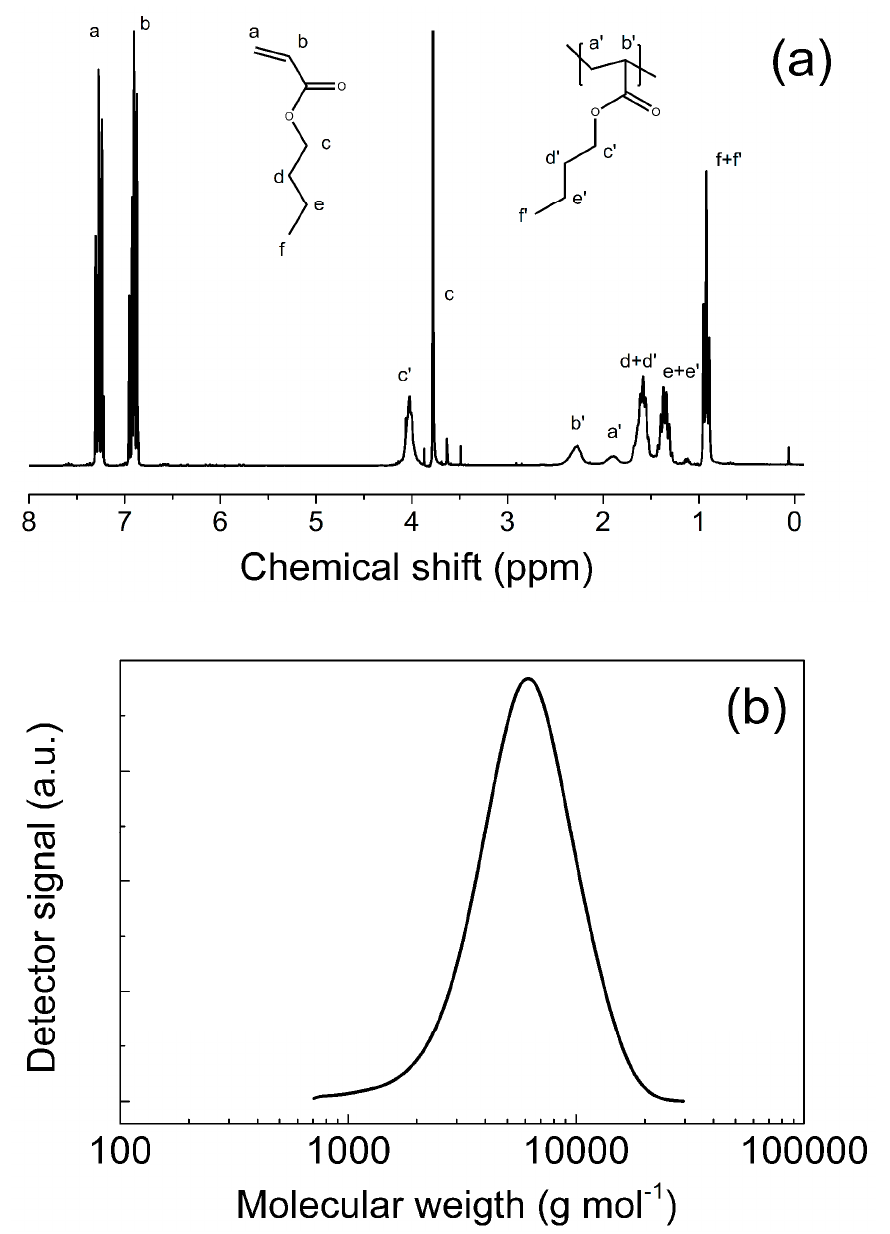
Figure 2. 1 HNMR spectra for n-butyl acrylate and PBA ( a ) and GPC trace of the controlled polymerization of PBA ( b ).